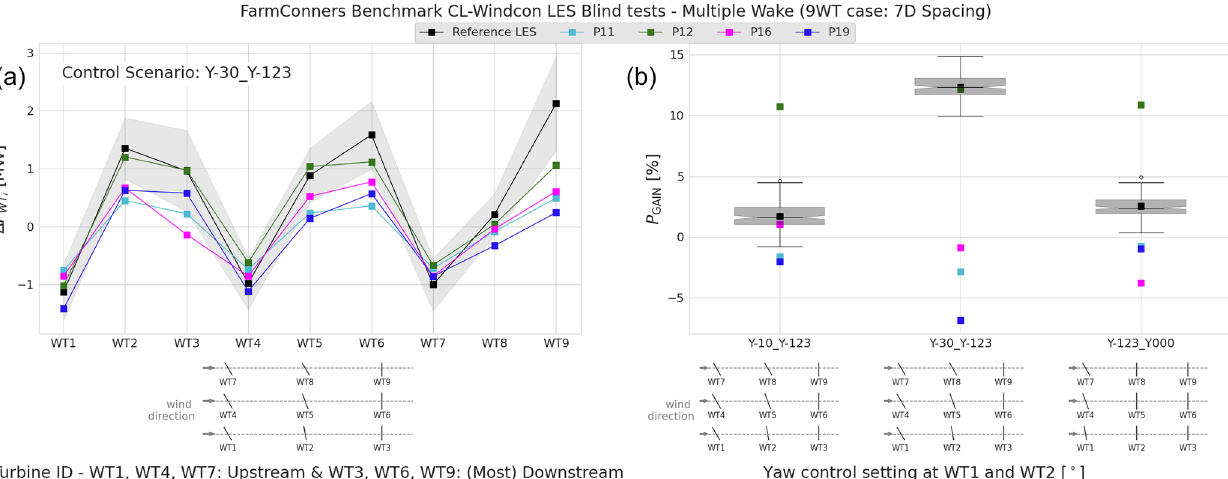
Figure 19. CL-Windcon LES blind tests, multiple wake under wake steering for the nine-turbine configuration (9WT) with 7D spacing. (a) Power difference (mean) in absolute values (MW) per turbine, for the control case Y-30_Y123 as shown in Table 7. (b) Power gain (mean) per control setting in the nine-turbine wind farm. Boxplots represent the distribution of the reference CL-Windcon LES time series per control setting listed in Table 7. Representative layouts with corresponding yaw control settings are illustrated along the x